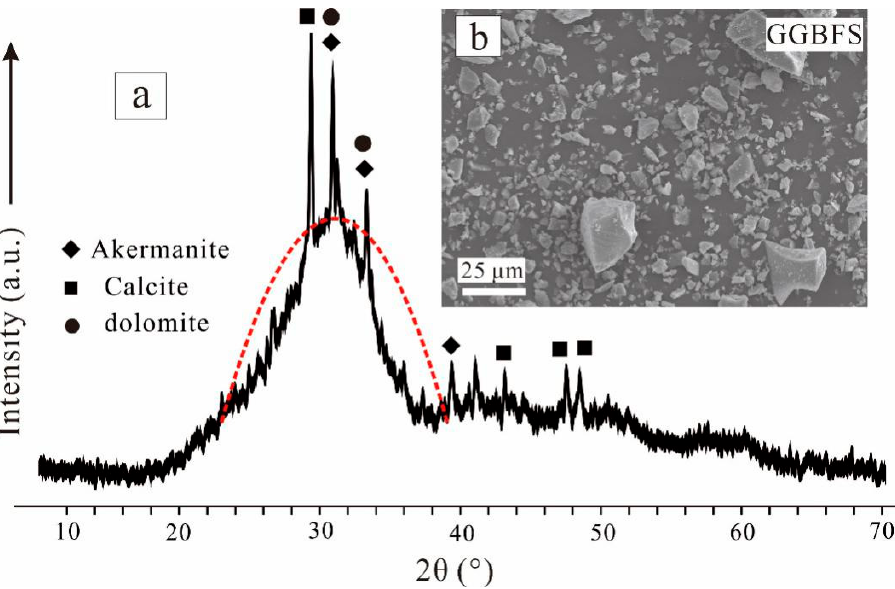
Figure 1. ( a ) XRD patterns and ( b ) SEM image of the